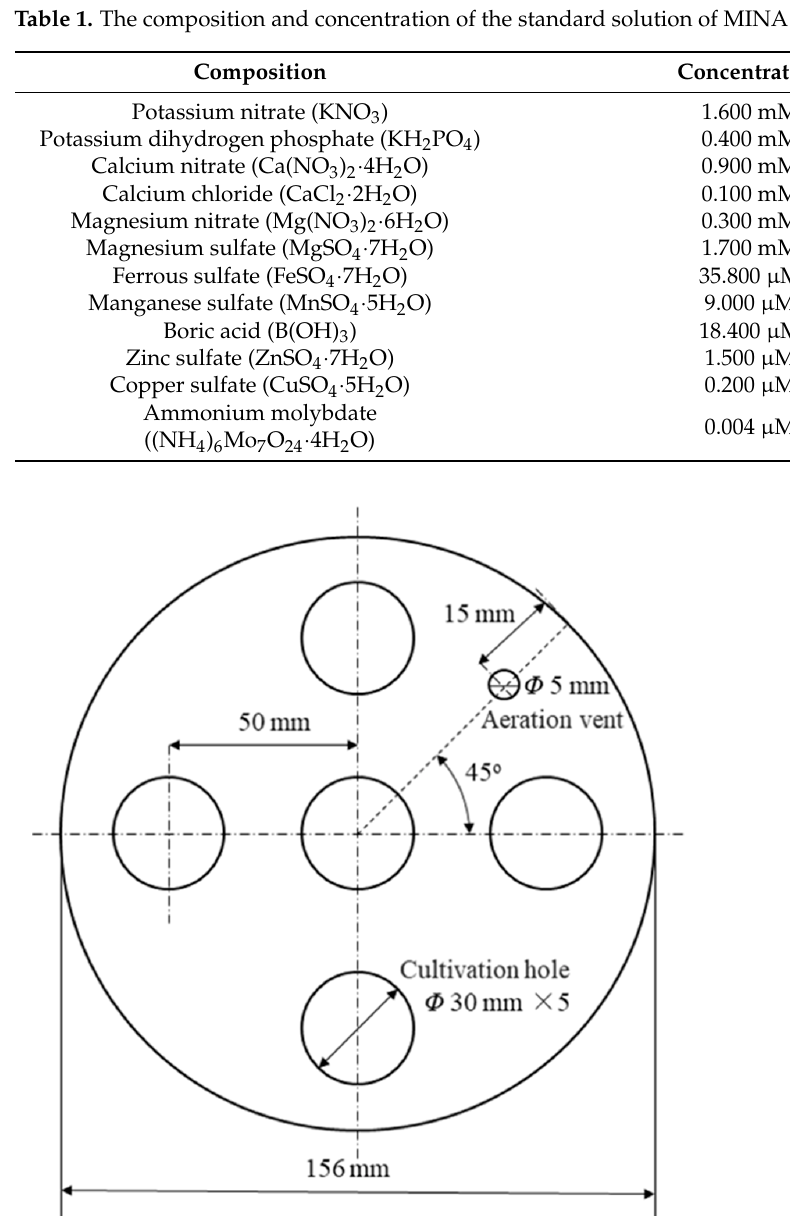
Figure 1. Dimensions of a cultivation plate.